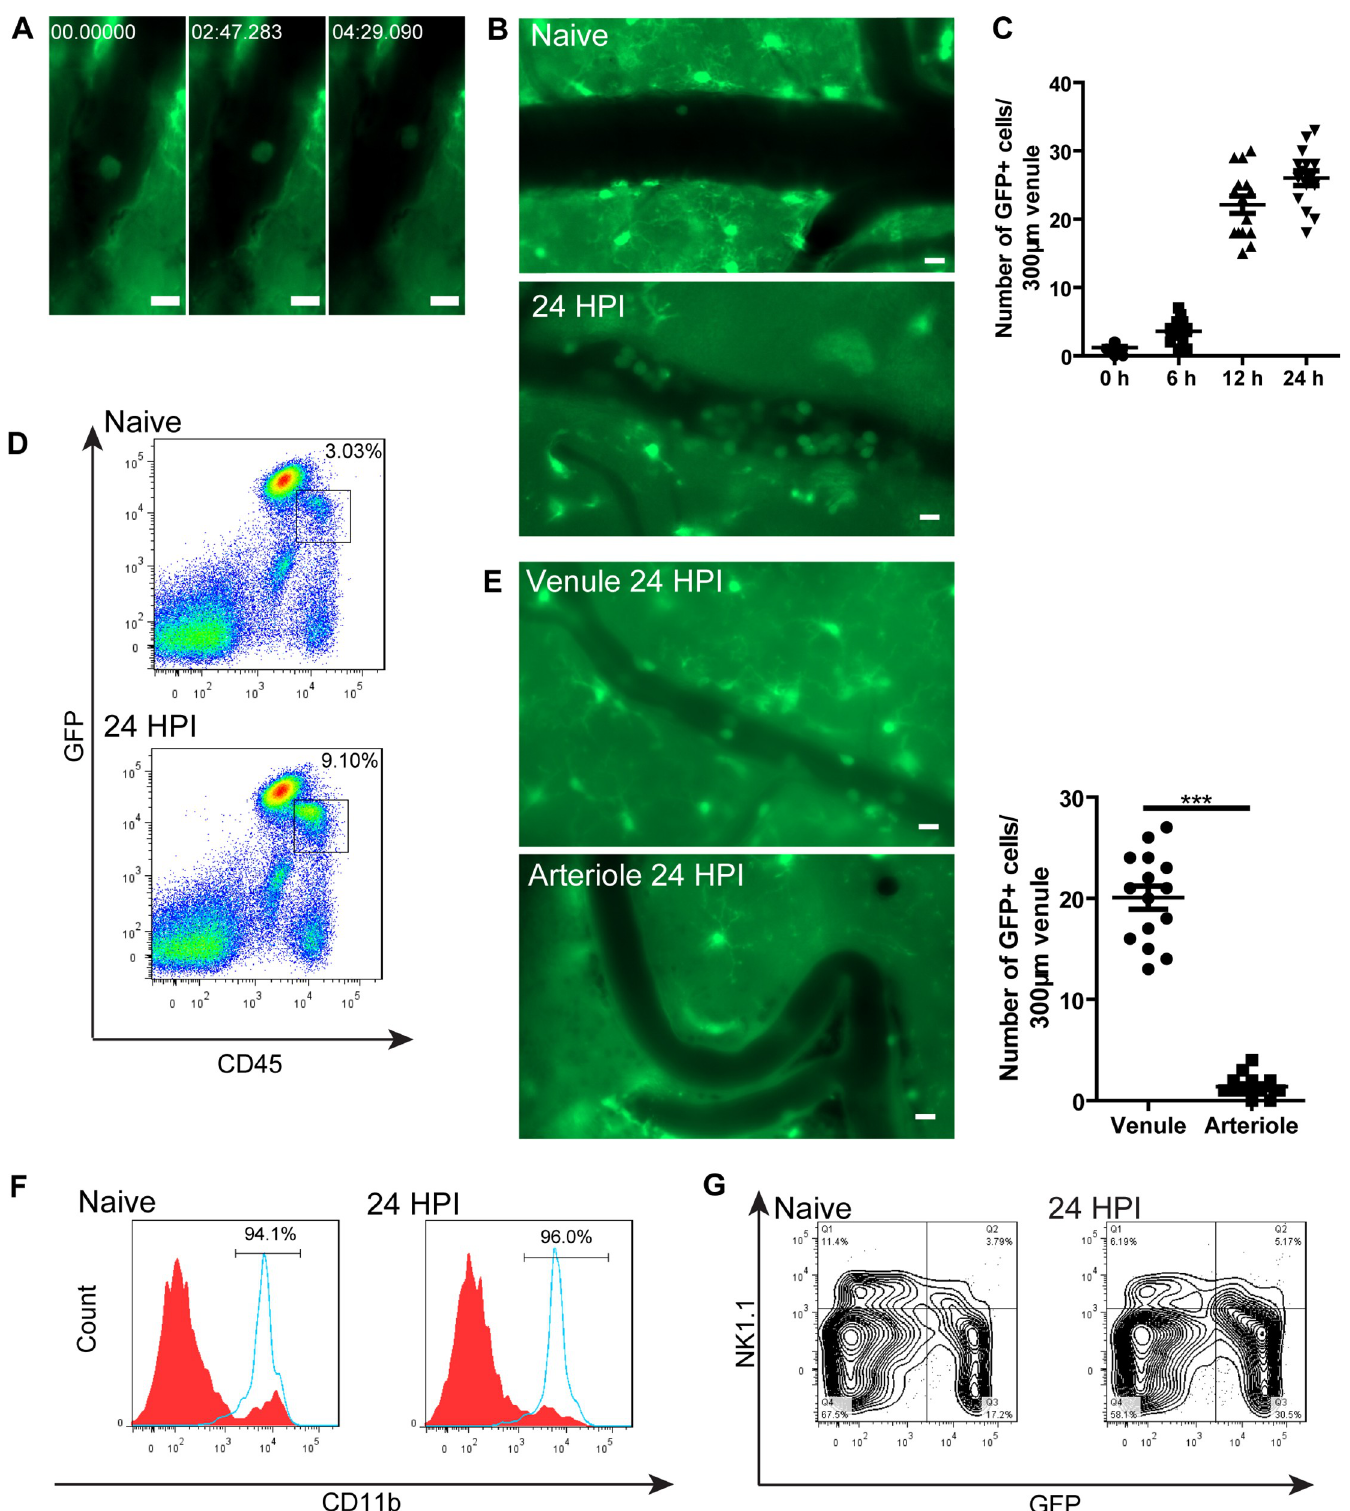
Fig 1. Monocytes patrol the brain postcapillary venules under resting conditions and are substantially recruited after C . neoformans infection. (A) A series of IVM images showing a GFP + cell crawling inside a brain postcapillary venule of a na ï ve CX3CR1 gfp/+ mouse. See also S1 Video. (B) Representative IVM images showing a substantial recruitment of GFP + cells to brain postcapillary venules of CX3CR1 gfp/+ mice 24 h after i.v. infection with 20x10 6 C . neoformans as compared to na ï ve mice.